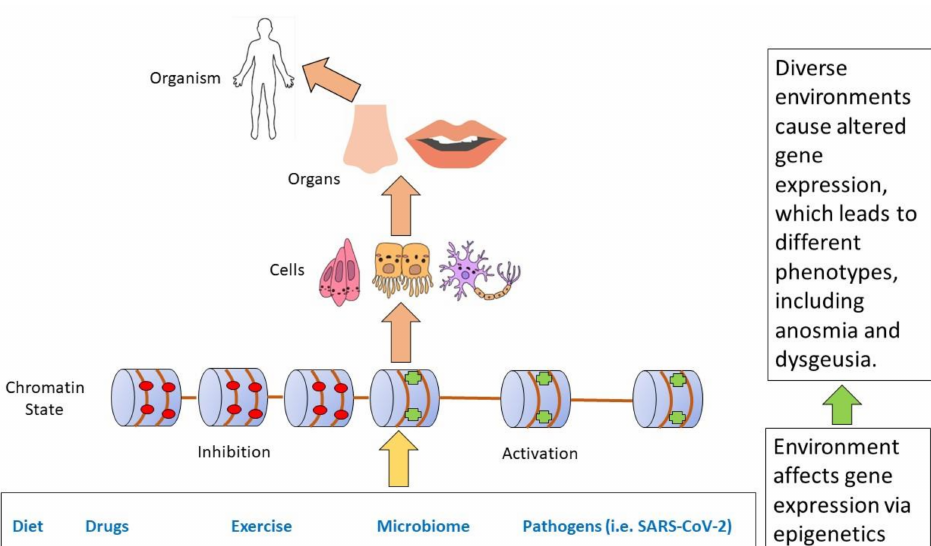
Figure 3. Gene-environment interactions during development and disease occur at different lev- els. Environmental factors can lead to either inhibition or enhancement of gene expression by incorporating these factors through epigenetic processes such as chromatin remodeling. While the environmental effects manifest themselves initially at the cellular level, they are then incorporated at all levels from cells to the whole organism. Disease etiology occurs in the same hierarchical sequence. In this particular case, SARS-CoV-2 alters epigenetic state contributing to anosmia and dysgeusia. Adapted from